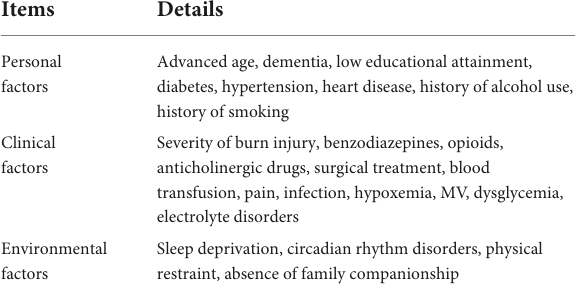
TABLE 2 Risk factors for delirium in burn patient’s